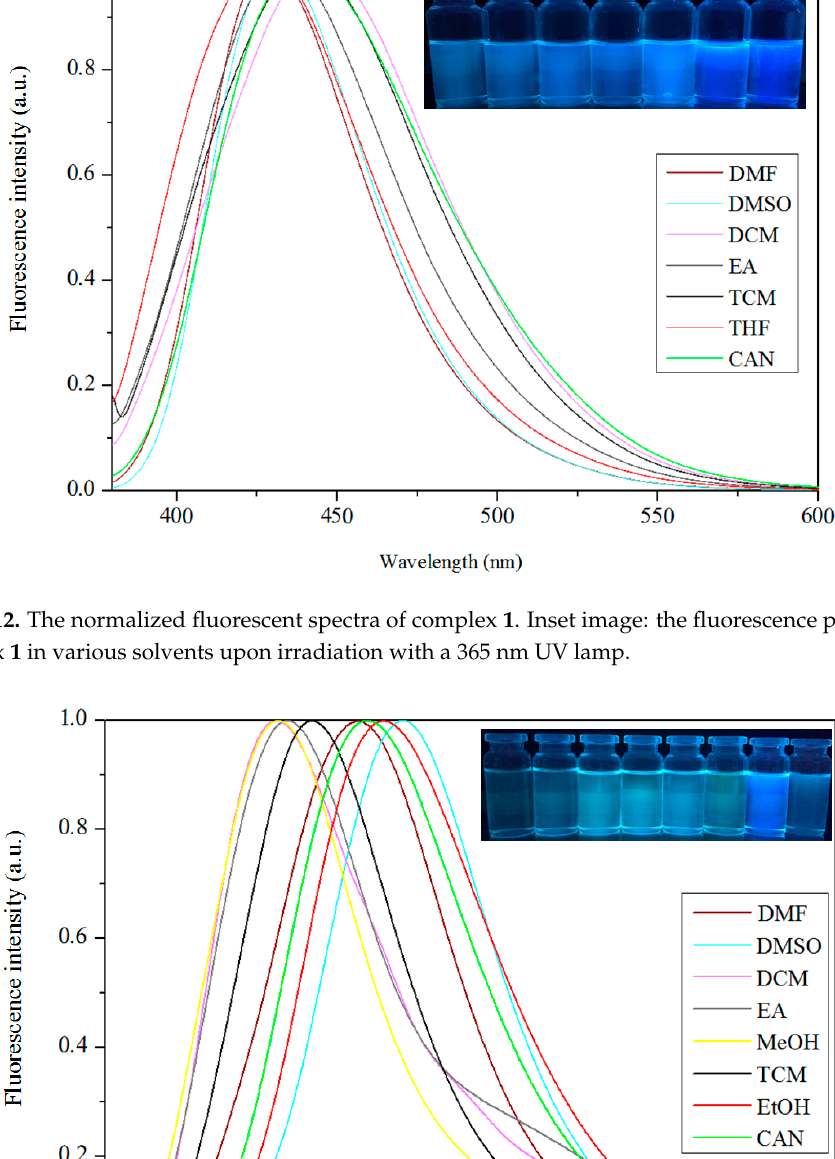
Figure 12. The normalized fluorescent spectra of complex 1 . Inset image: the fluorescence picture of complex 1 in various solvents upon irradiation with a 365 nm UV lamp.